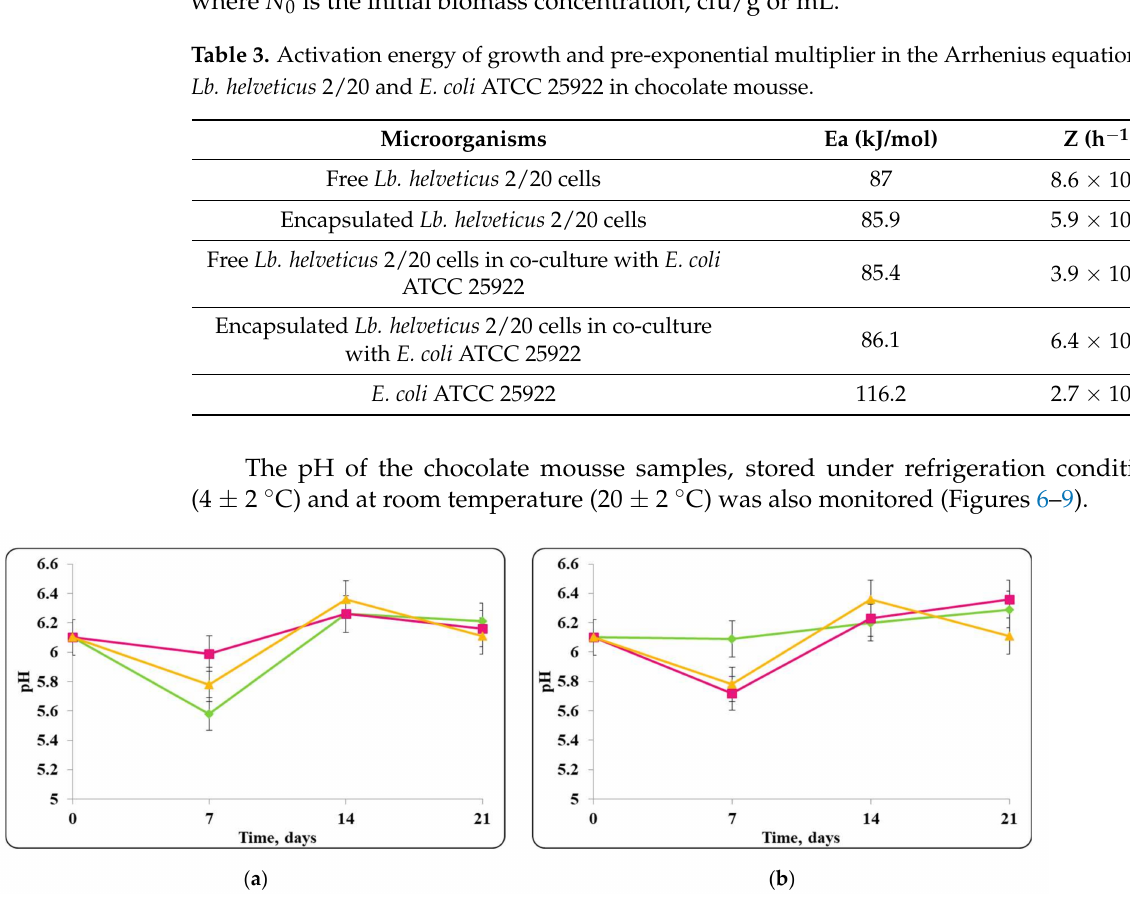
Figure 6. ( a ) free lactobacilli cells; ( b ) encapsulated lactobacilli cells. Changes in the pH of chocolate mousse inoculated with Lb. helveticus 2/20 and E. coli ATCC 25922 during storage at 4 ± 2 ◦ C. Legend: Green (cid:117) : pH of chocolate mousse inoculated with Lb. helveticus 2/20; Pink (cid:4) : pH of chocolate mousse co-inoculated with Lb. helveticus 2/20 and E. coli ATCC 25922; Yellow (cid:78) : pH of chocolate mousse inoculated with E. coli ATCC